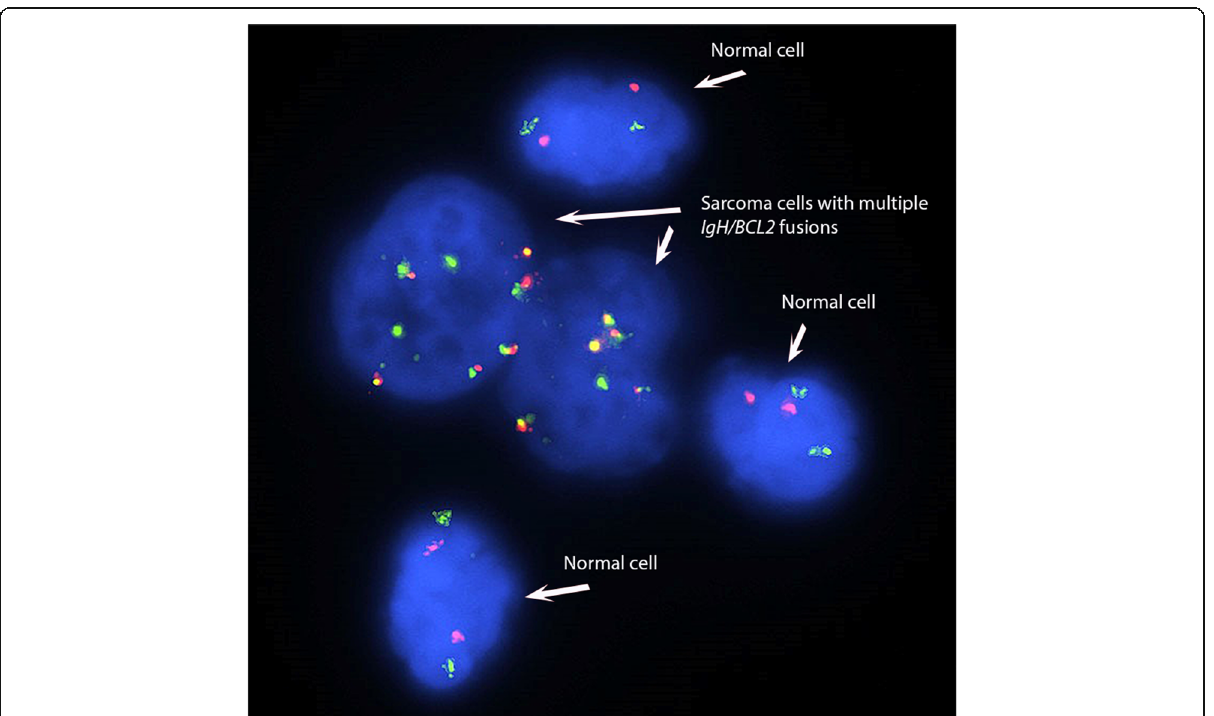
Fig. 5 Dual color dual fusion FISH analysis demonstrates multiple IgH/BCL2 fusion signals resulting from t(14;18) in 21% of cells analyzed. The fusion signals are present only in the large sarcoma cells with but not in any of background inflammatory cells